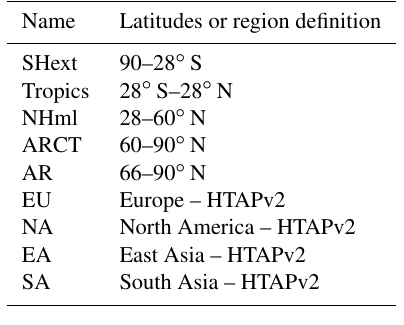
Table 1. Latitudinal band definitions and region definitions.